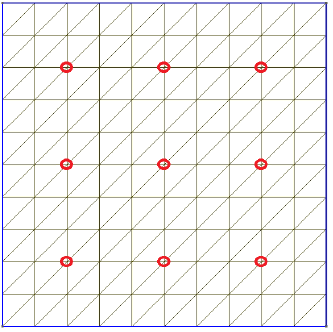
Figure 1. Selected vertices from the computational